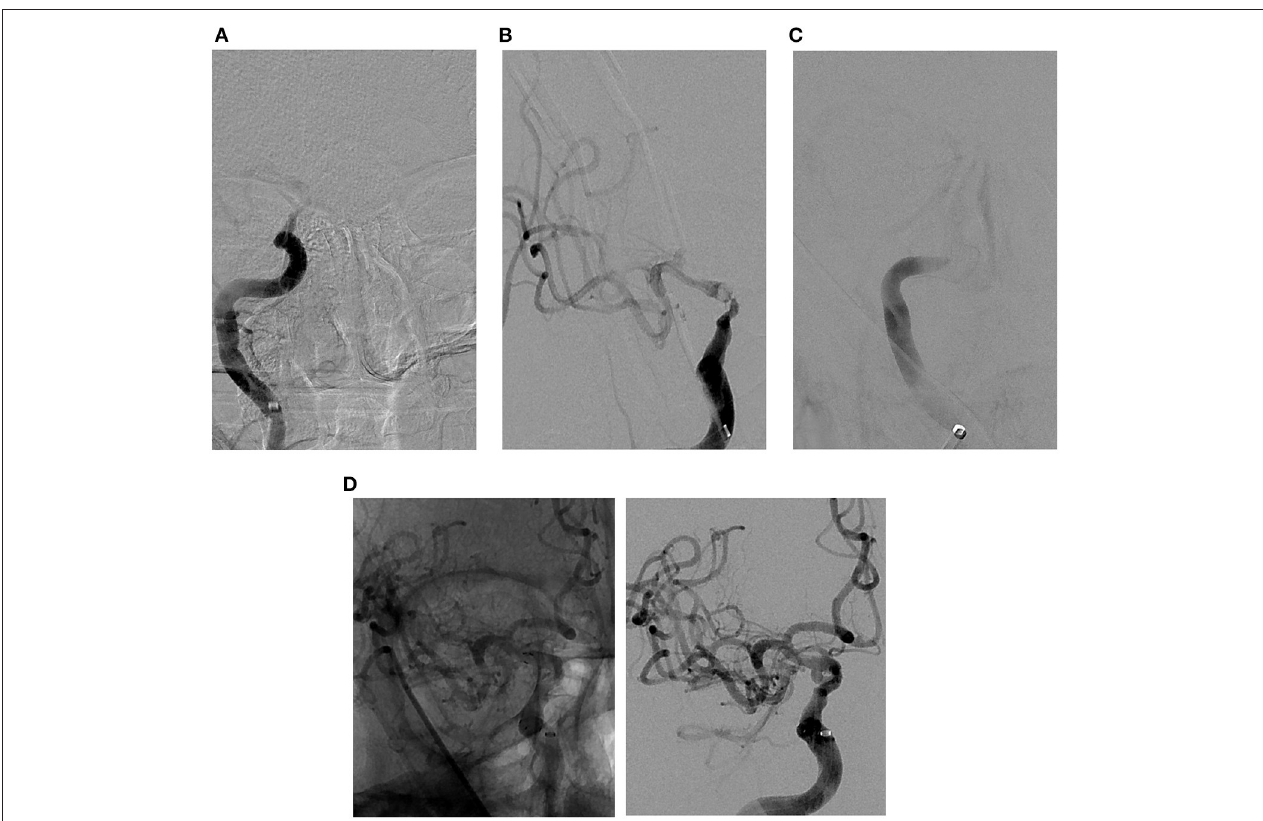
FIGURE 4 | Illustrative case of ICAS-related LVO in the cavernous segment of the right internal carotid artery. (A) Pre-MT angiographic image demonstrating complete occlusion of cavernous segment of the right internal carotid artery. (B) Post-MT angiographic image demonstrating partial recanalization of cavernous segment of the right internal carotid artery with persistent severe stenosis. (C) Delayed angiographic image 5min post-MT demonstrating re-occlusion of the intracranial internal carotid artery. (D) Native (left) and digitally subtracted (right) angiographic images demonstrating successful angioplasty and stenting as a rescue therapy, with a significant improvement in the severe stenosis and near complete recanalization of the right internal carotid artery. ADAPT, a direct aspiration first pass technique; MT, mechanical thrombectomy; ICAS, intracranial atherosclerosis; ELVO, emergent large vessel